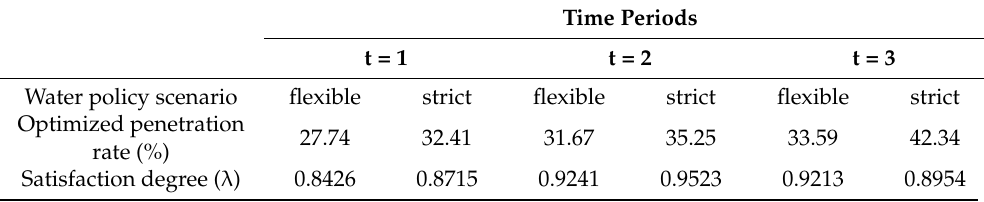
Table 5. The optimized renewable energy penetration and the satisfaction degree of the system.